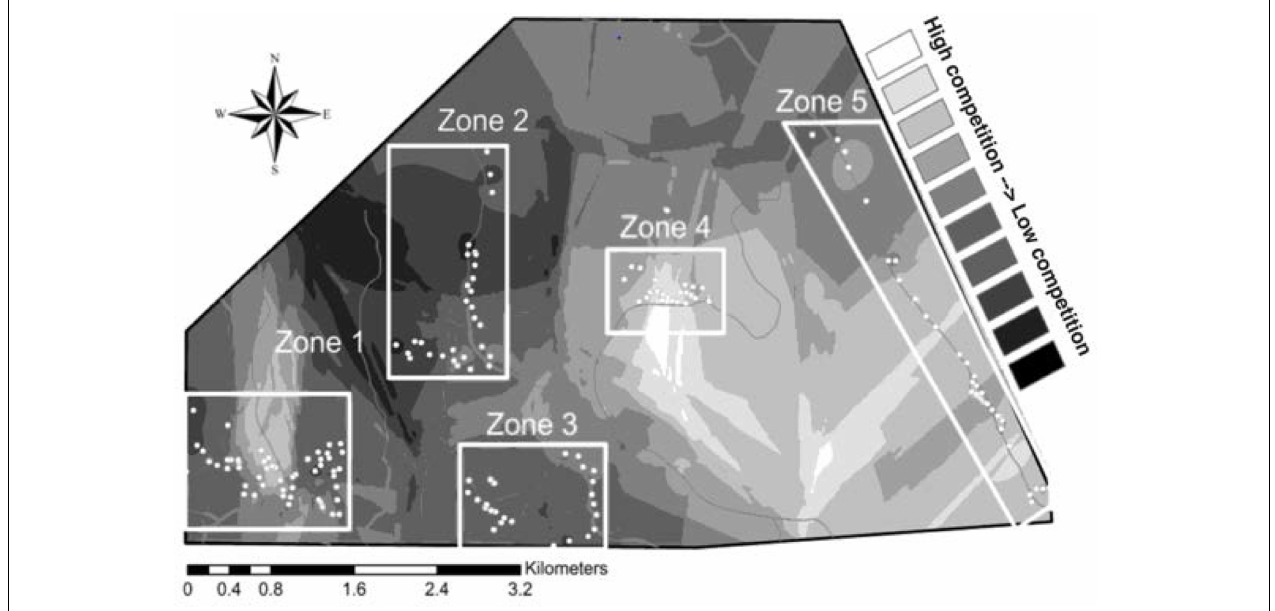
FIGURE 1 | Interpolation of the occupancy ratios of eastern bluebirds to tree swallows throughout the field site. The ratio is: bluebird occupancy rate over the past 4 years/tree swallow-occupancy rate of the past 4 years. Low-competition sites: Zone 2 and Zone 3; high-competition sites: Zones 1, 4, and 5.